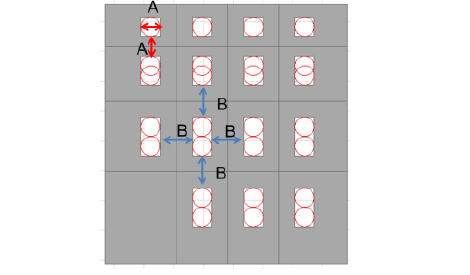
Figure 4. Proportions and parameters used for design of parametric façade.